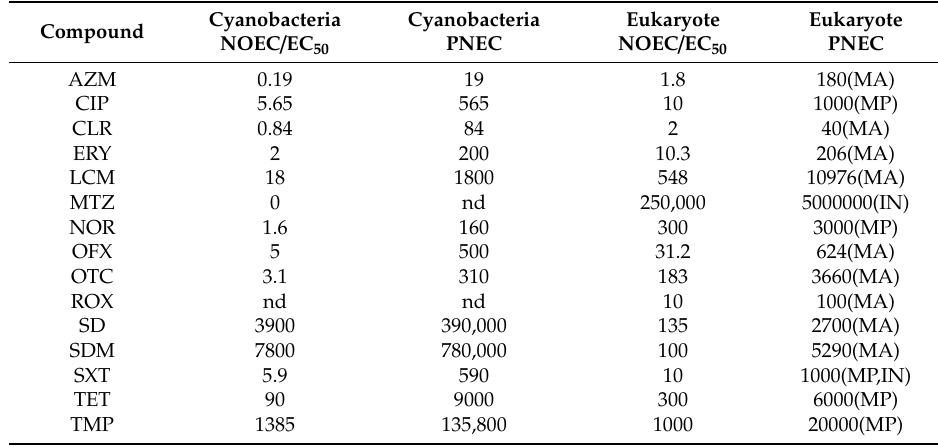
Table A4. NOEC / EC 50 ( µ g / L) and PNEC (ng / L) used for the risk assessment; nd, no data available. Abbreviations in parentheses indicate the most sensitive taxa: MA, microalgae; MP, macrophytes; IN, invertebrates. The data based on the review of Le Page